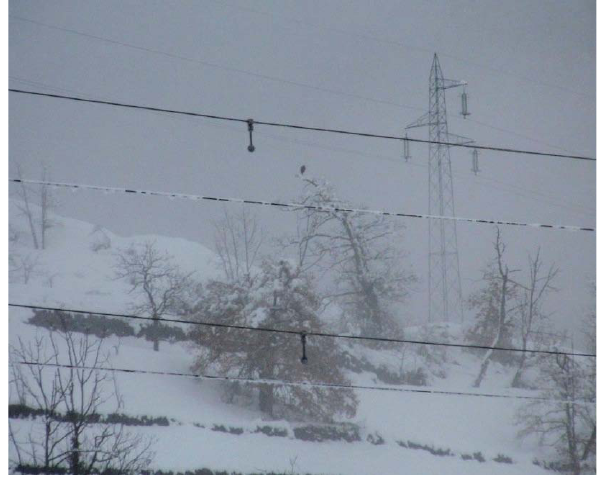
Fig. 1. Counterweights on a 132kV power line limit the wet snow accretion on wires (Valle Stura – Piedmont – Italy; 19 Febru- ary